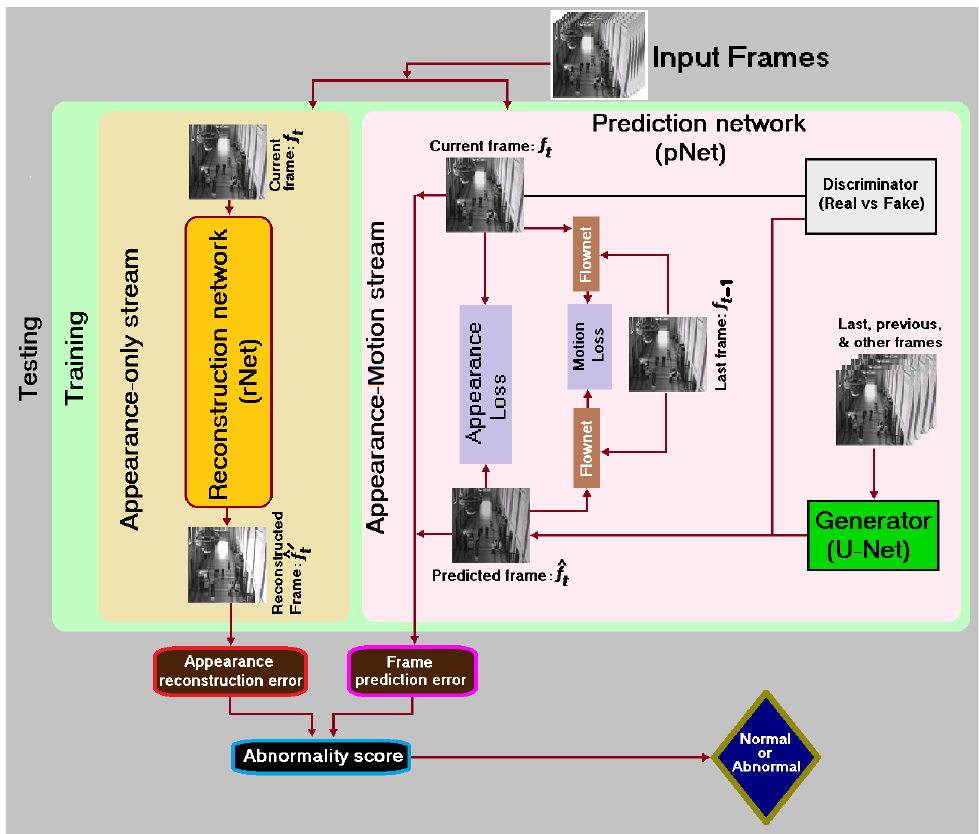
Figure 1. Generalized architecture (rpNet) of our proposed anomaly detection